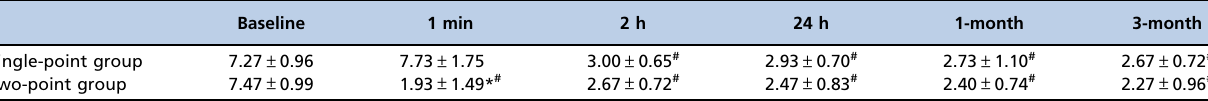
Table 2 - The VAS at different time points (mean ± SD, n=15).